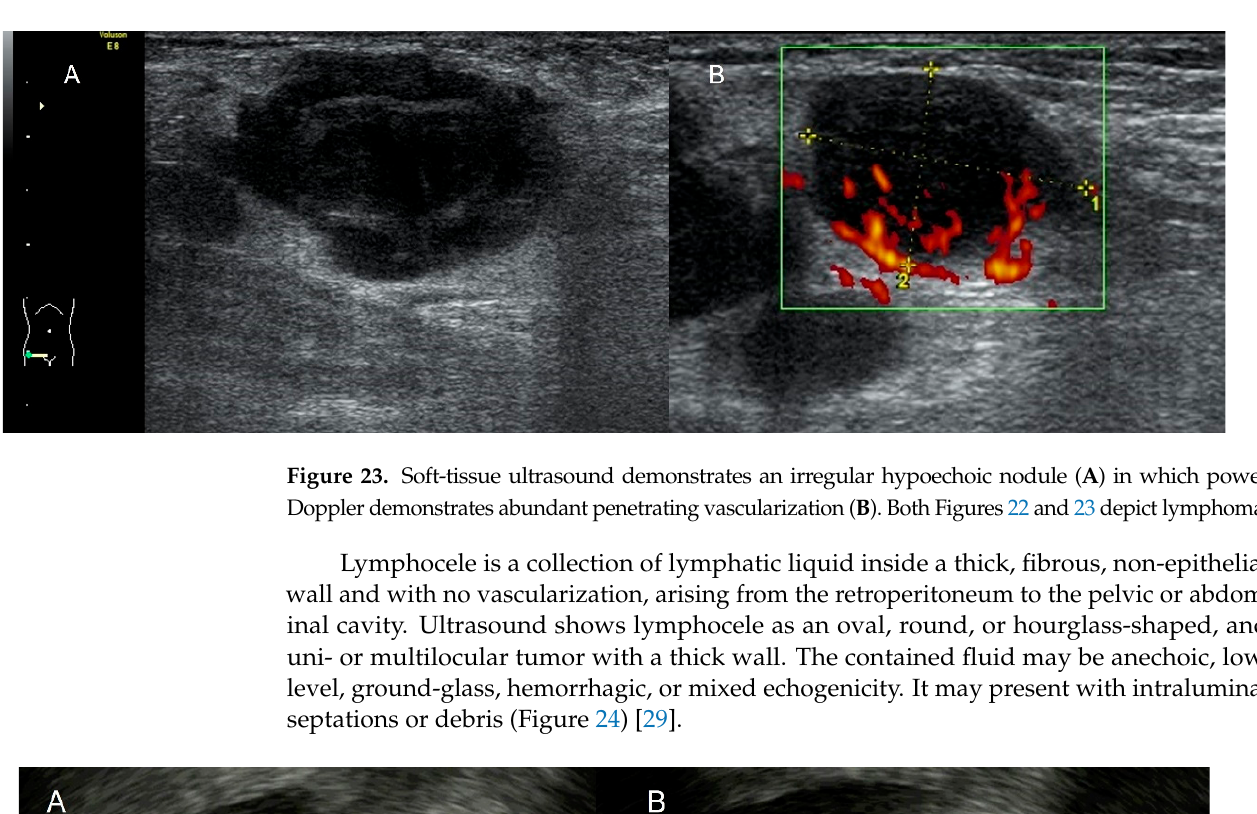
cyst, renal cyst, or other diseases should be carried out.